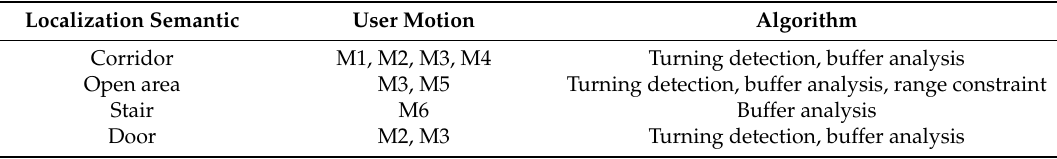
Table 2. The relationship between space type, user motion, and the corresponding algorithms. Localization